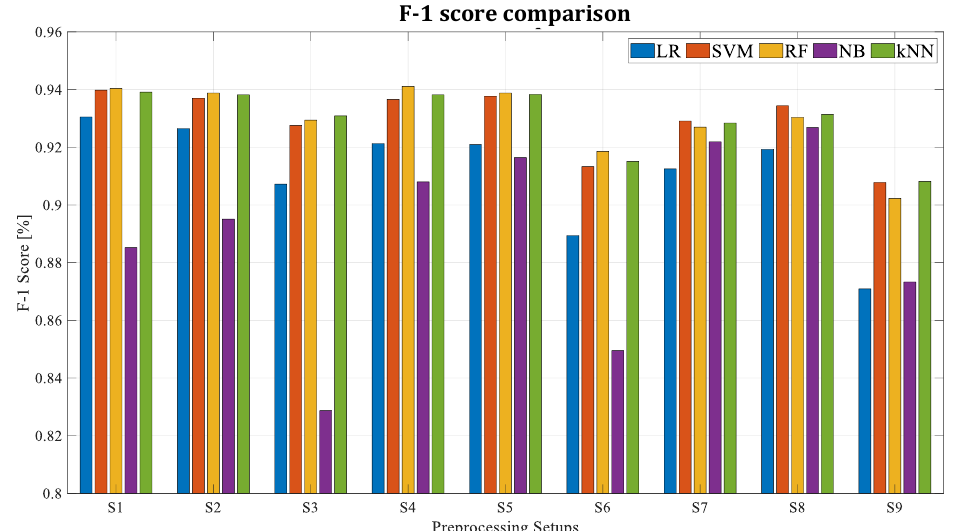
Figure 9. F-1 score for different algorithms and dataset configurations.